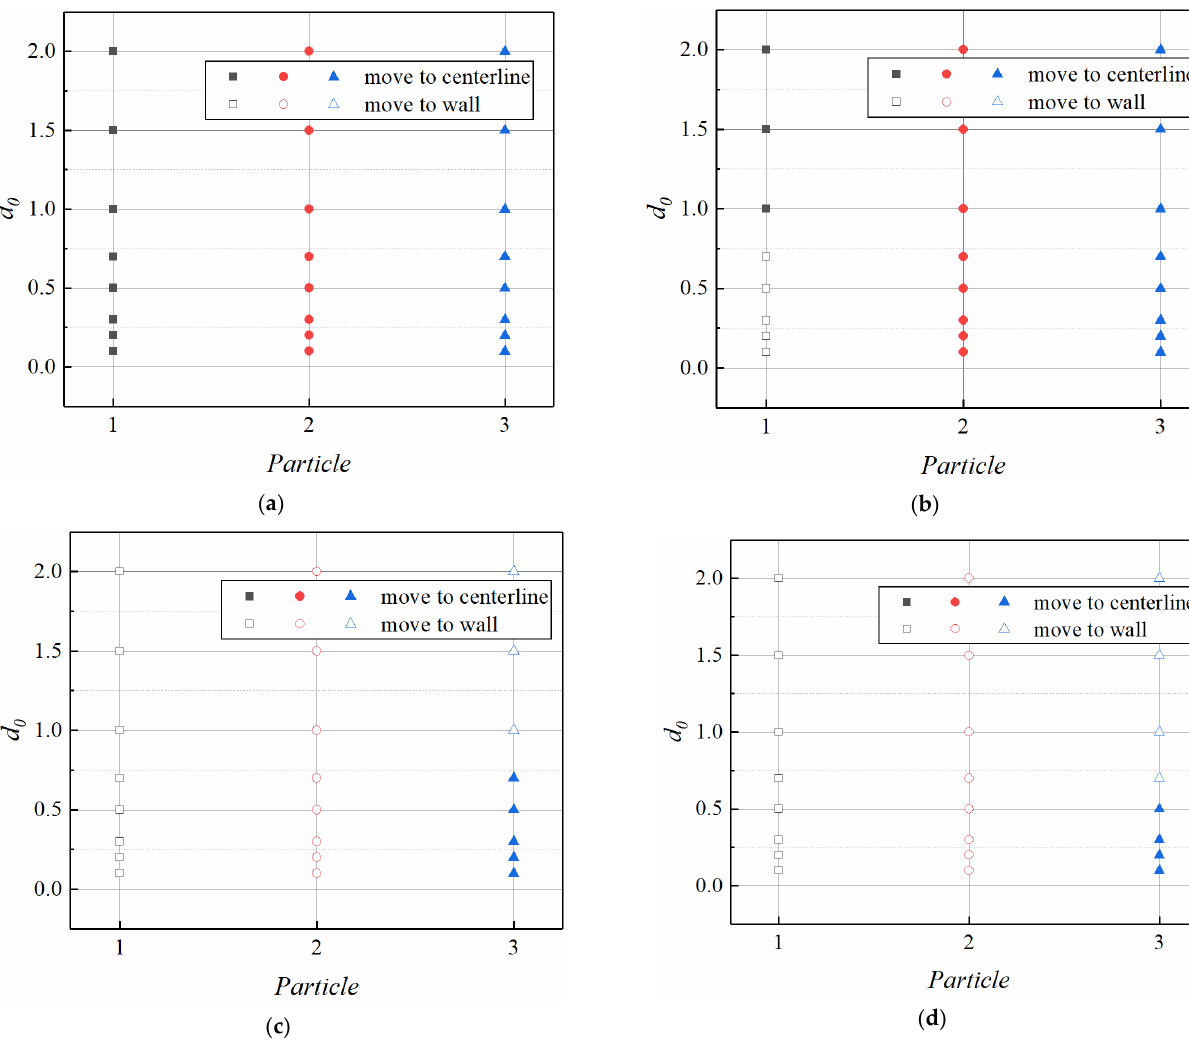
Figure 15. Direction of three particles migration for different initial interparticle distances and mobility parameters ( Wi = 0.5,